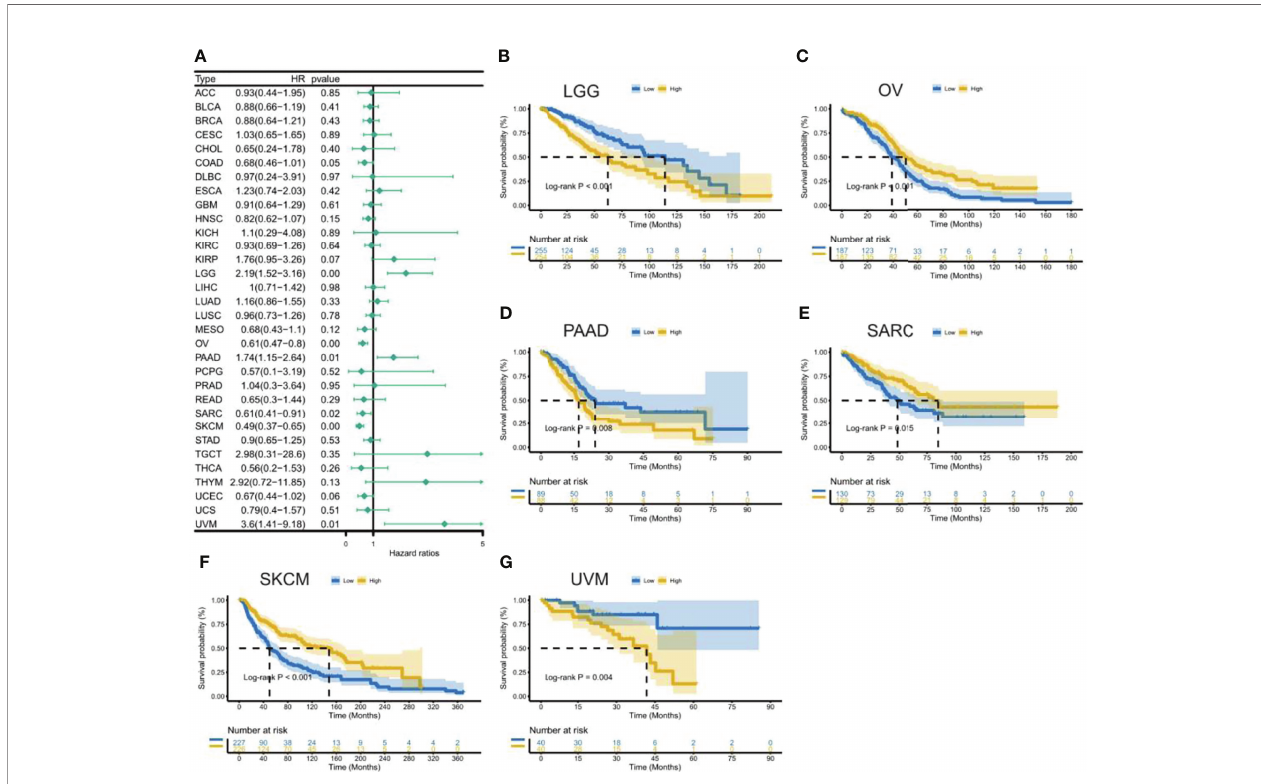
FIGURE 3 | Association between CXCL11 expression and overall survival (OS). (A) Forest plot of OS association across cancers. (B – G) Kaplan – Meier analysis of the association between CXCL11 expression and OS in LGG, OV, PAAD, SARC, SKCM, and